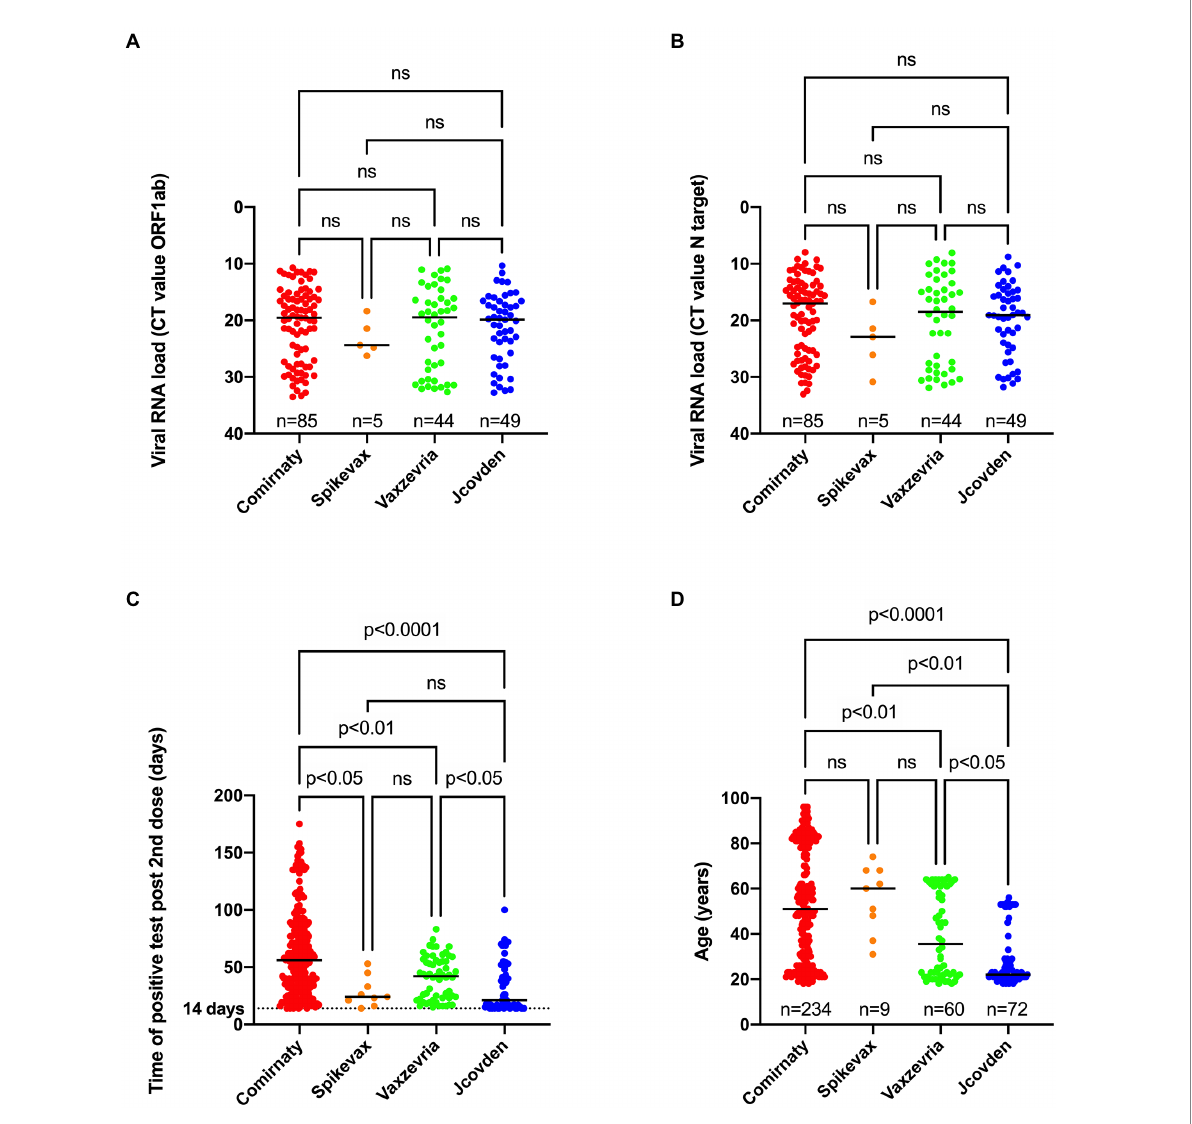
FIGURE 5 Relationship between type of vaccine used and viral RNA load obtained for ORF1ab (A) , N target (B) , time of positive SARS-CoV-2 test after receiving the second dose (C) or age (D) . A Kruskal-Wallis test was performed to compare median CT value for ORF1ab (A) , N target (B) , the median time of positive RT-PCR test after receiving the second dose (C) and the median age (D) between the four types of vaccines. When a statistically significant result was obtained, Dunn’s multiple comparison test was performed post hoc to identify which groups significantly differed. ns, not significant.